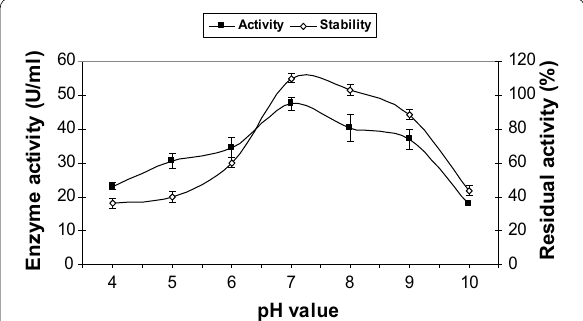
Fig. 1 Activity and stability of l -glutaminase produced by Bacillus sp. DV2-37 as a function of pH values. Results are means of three independent determinations. Data represent the mean of 3 different readings standard ±